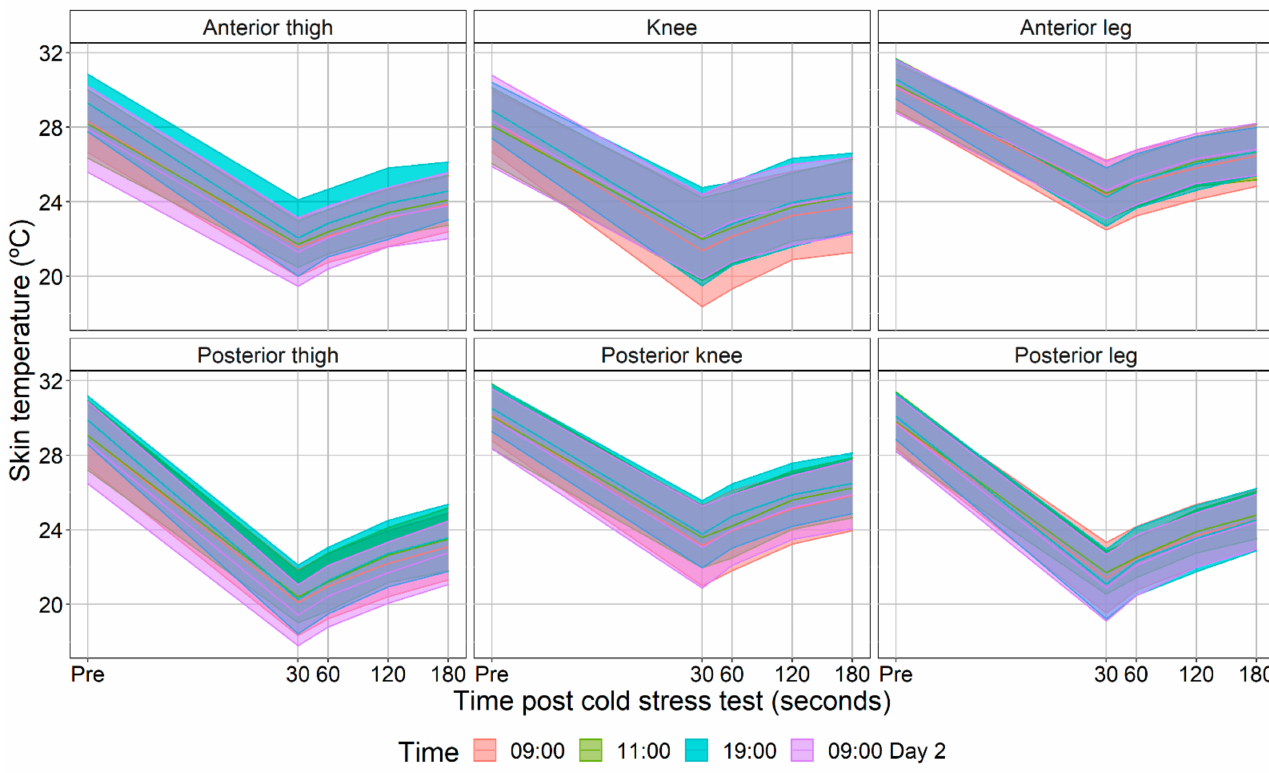
Figure 3. Mean and standard deviation of the evolution of skin temperature before (Pre) and 30, 60, 120, and 180 s after cold stress test at each measurement